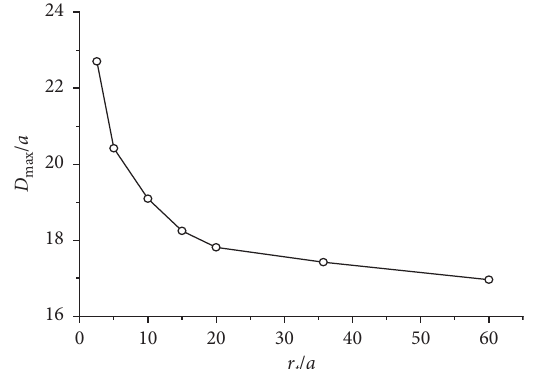
Figure 14: Influence curve of the target size on the penetration